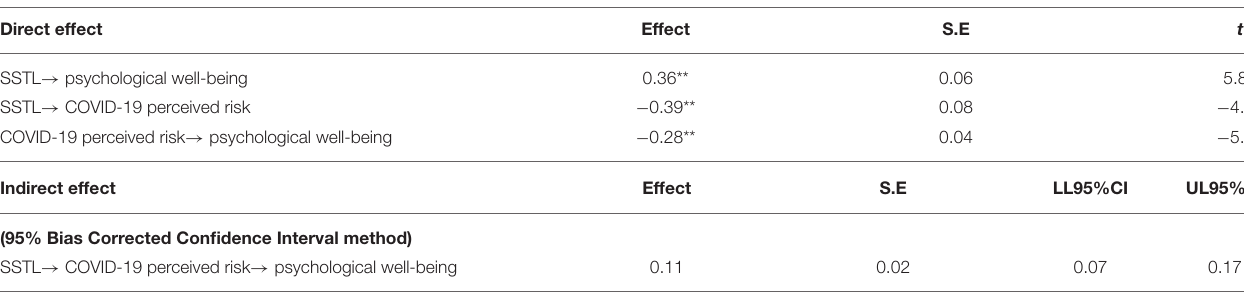
TABLE 2 | Bootstrapping results for direct and indirect effects.